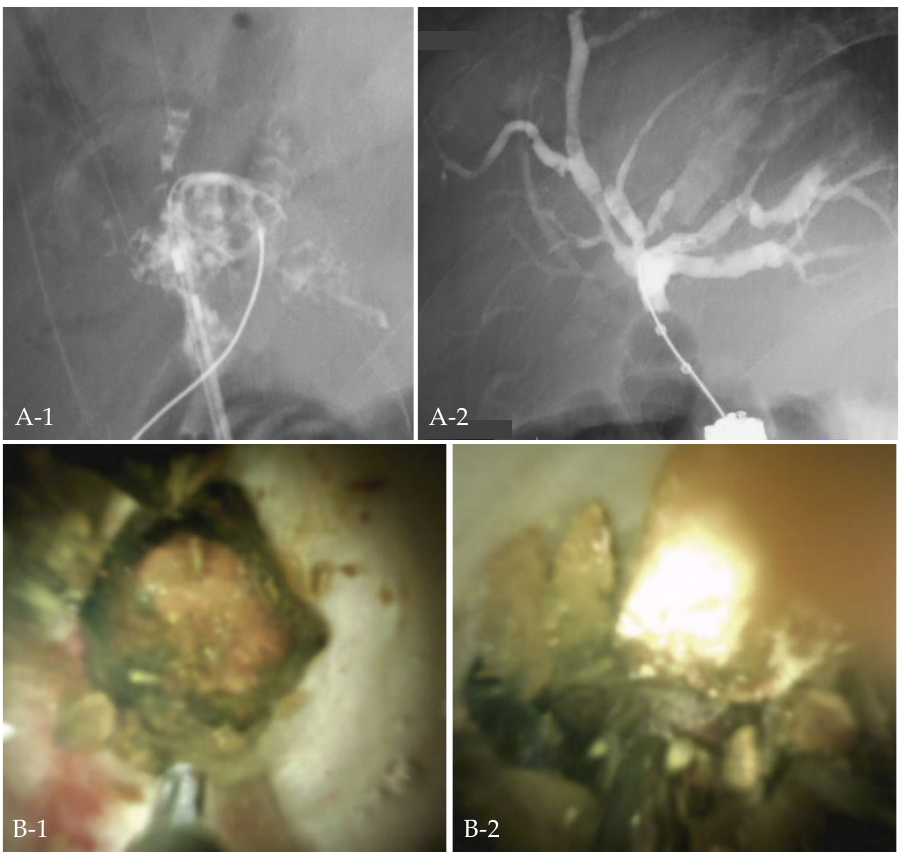
Figure 3. Case 3. Cholangitis developed in a patient after pancreaticoduodenectomy, and the bile duct was filled with stones ( A-1 ). Electrohydraulic shockwave lithotripsy under oral cholangioscopy with colonoscopy was performed ( B-1 , B-2 ), and all stones were removed ( A-2 ).